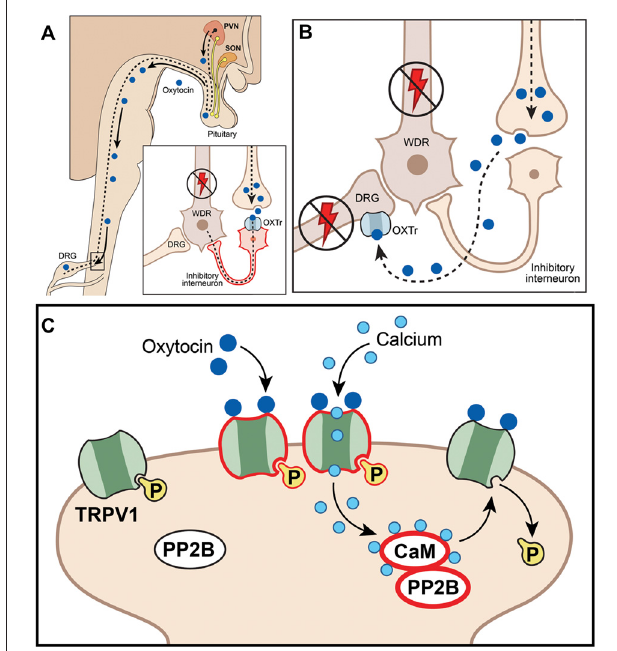
FIGURE 2 | Schematic illustration of putative mechanisms explaining anti-hyperalgesic actions of the endogenous oxytocin (OXT) system in orofacial pain conditions. (A) Paraventricular nucleus (PVN) afferents projected to spinal cord release OXT, act on spinal neurons (including interneurons) and inhibit nociception; WDR, wide dynamic range spinal neurons; OXTr, OXT receptor; DRG, dorsal root ganglion. (B) OXT inhibits neurotransmission at DRG (or trigeminal ganglia, TG) by directly activating OXTr on central terminals, inhibiting activation and firing of dorsal horn wide-dynamic-range neurons. (C) OXT inhibits DRG (or TG) neurons by directly activating TRPV1, inducing Ca 2 + influx and triggering desensitization mechanisms involving the calcineurin (PP2B)-calmadulin (CaM) pathway, which dephosphorylates TRPV1 and other channels (including